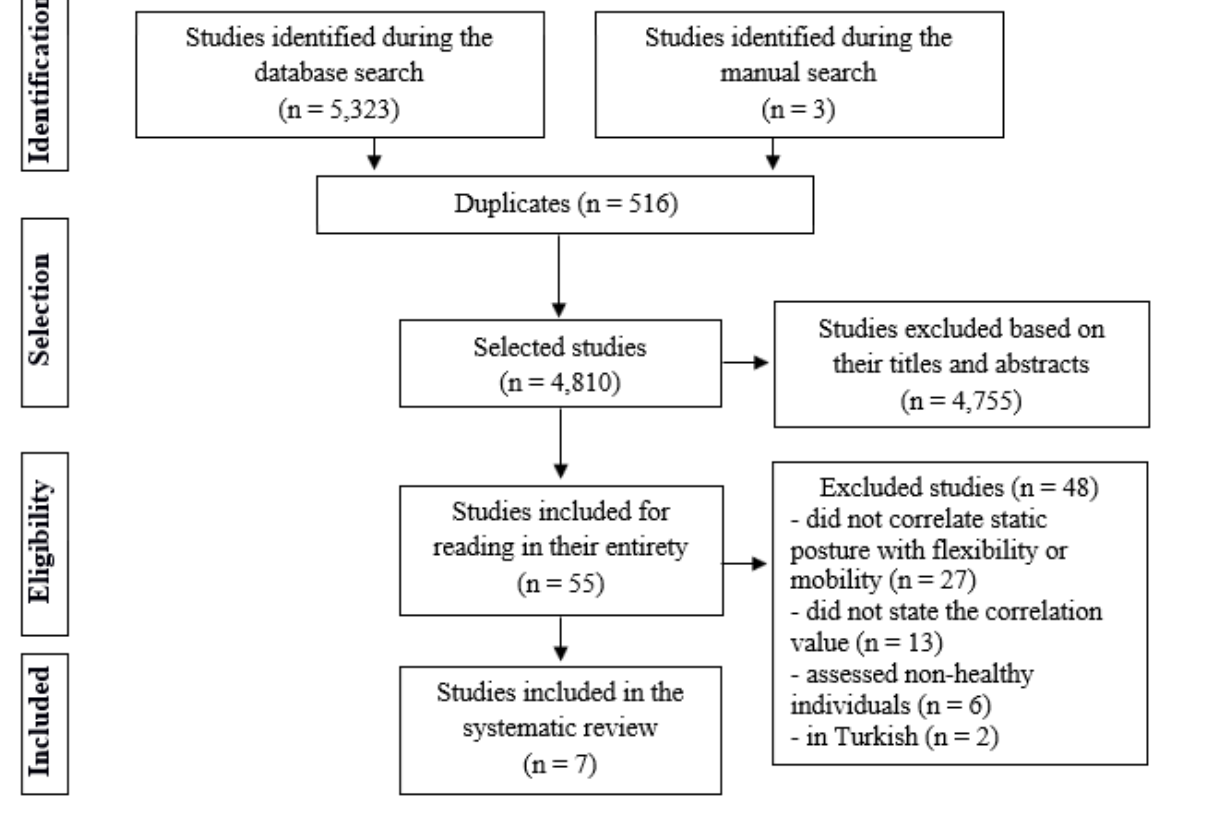
Figure 2 - Flowchart of the study inclusion stages in the systematic